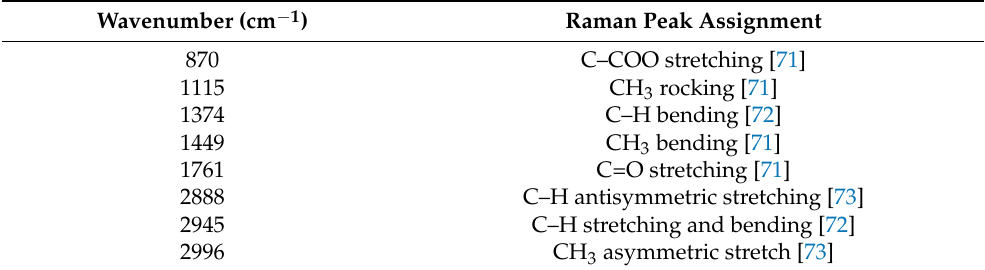
Table 2. Major Raman peaks identified and their related